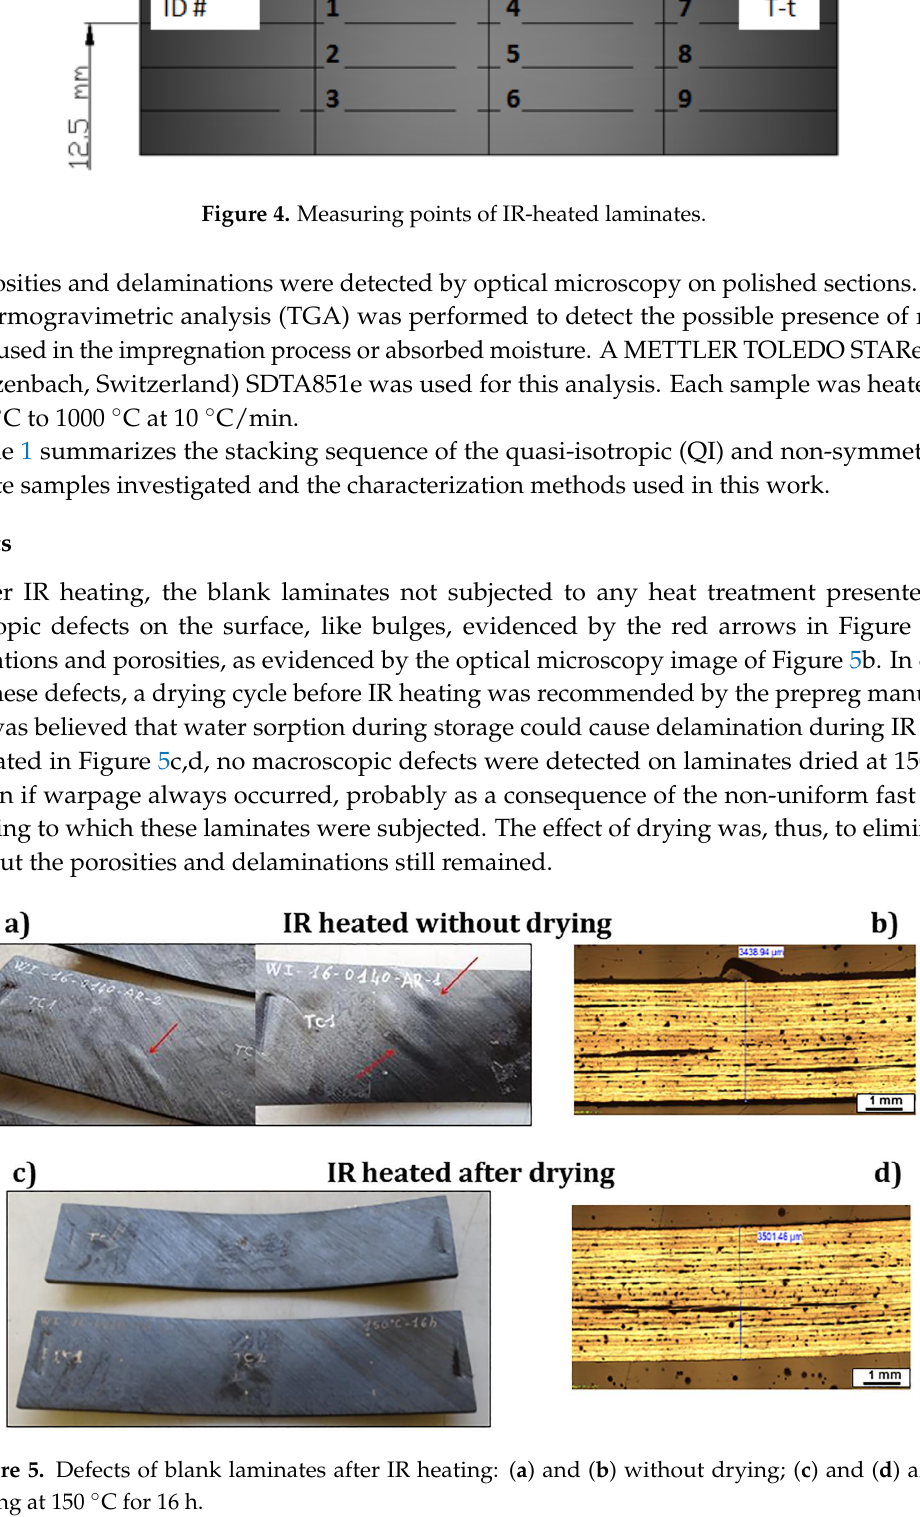
Table 1. Composite samples analyzed in this work and the characterization methods.